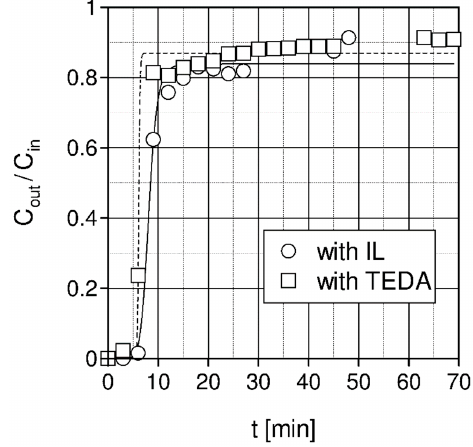
Figure 5. Comparison of measured CO 2 concentration for adsorption on pelletized activated carbon (4 mm) bed impregnated with ionic liquid [Emin][Ac] and on pelletized activated carbon coconut (4 mm) bed impregnated with TEDA amine ( 1 bar, temperature 20 °C, Cin = 10% vol. and gas flow rate Vg = 750 L/h).